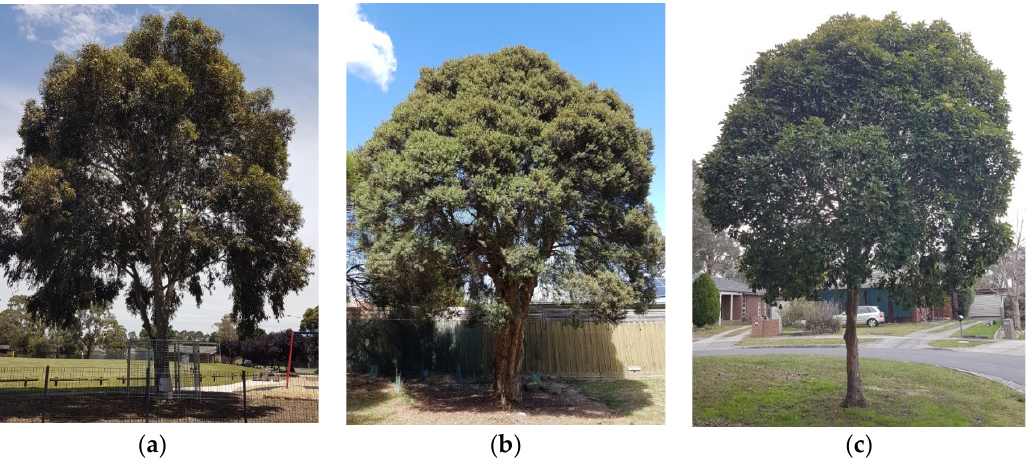
Figure 1. Examples of the three Australian native tree species ( a ) C. maculata ( b ) M. styphelioides ( c ) L. confertus used in these experiments.